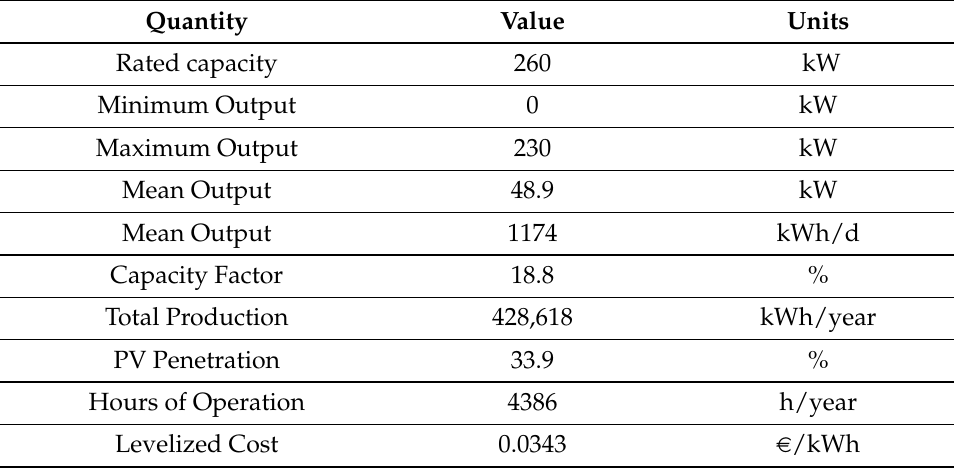
Figure 13. PV power output Scenario 2. Table 16. PV Scheme Simulation